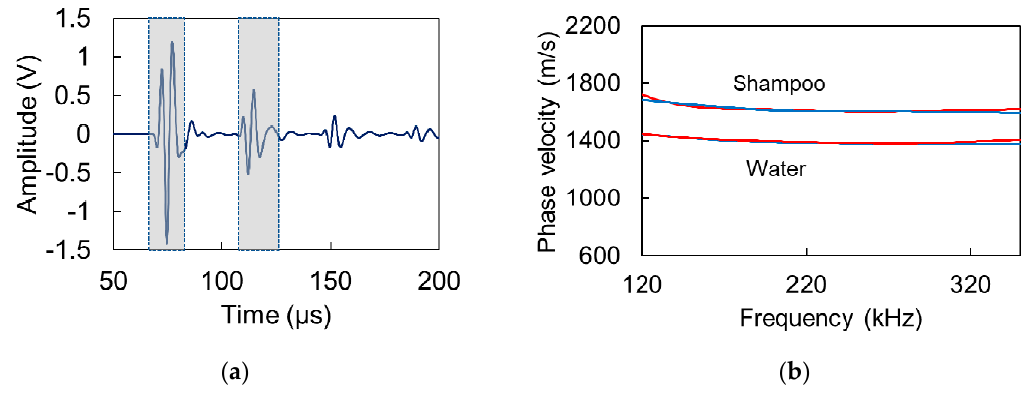
Figure 15. ( a ) Parts of signal used for dispersion analysis in grey windows (initial response and 1st reflection) and ( b ) dispersion curves for water and shampoo calculated based on the phase difference between face-to-face sensor signal and initial response (red) and between initial response and 1st reflection (blue).